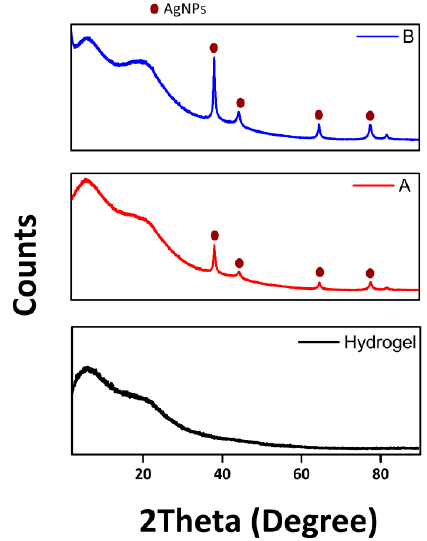
Figure 9. X-ray diffractograms of the hydrogel and the nanocomposites.